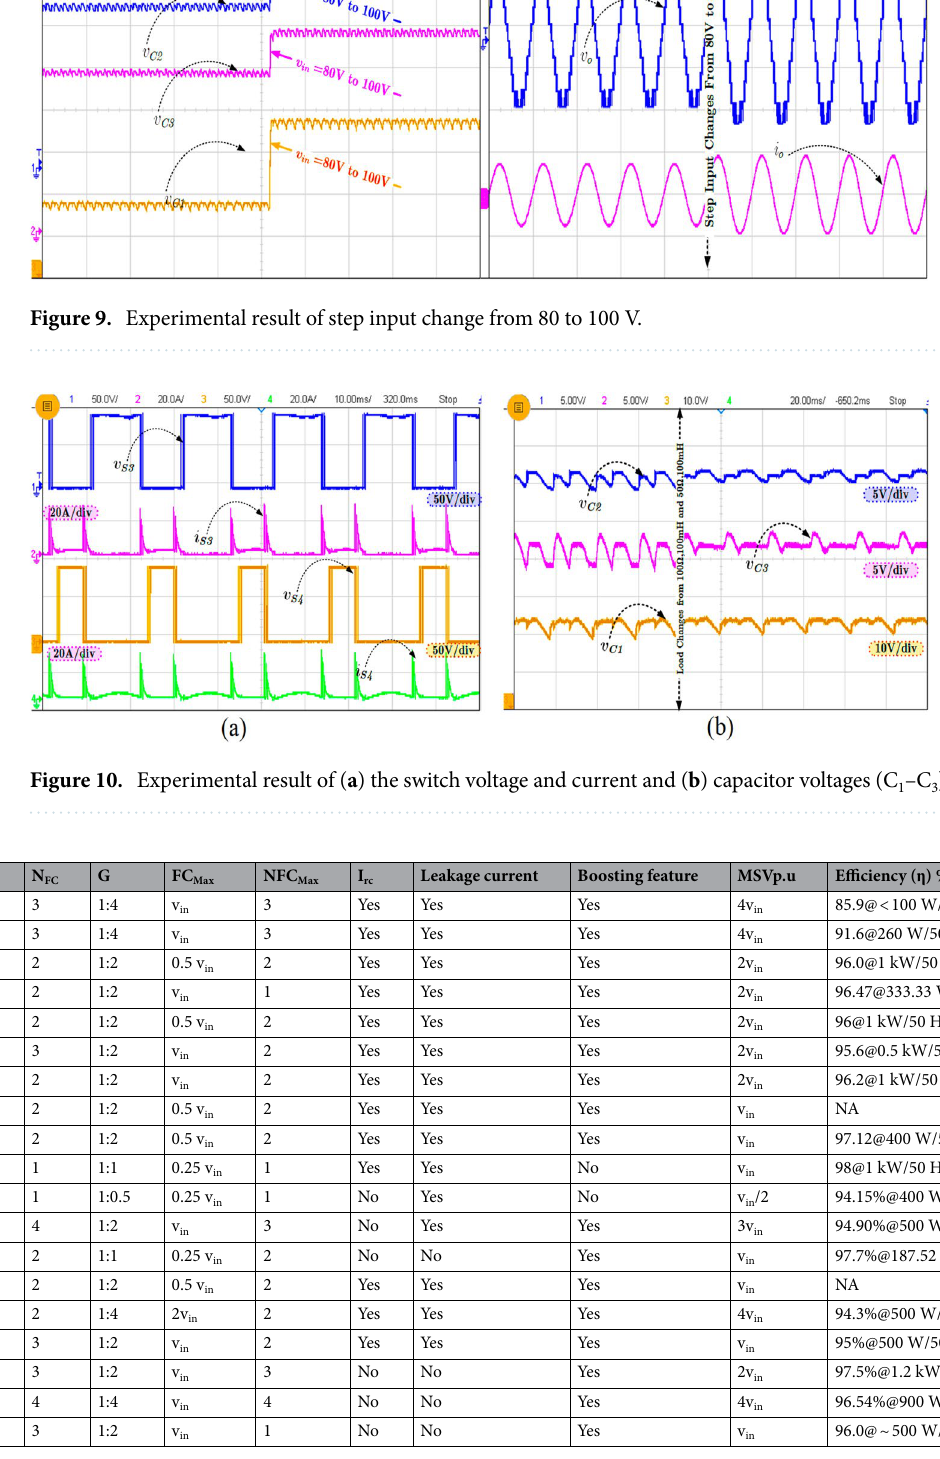
Table 3. Comparison of proposed topology with other recent nine-level inverter topologies. N SW /N GD / N D /N FC —number of switches/gate driver/diode/floating capacitor, T Comp —total component count, F CMax — maximum voltage rating of FC, NFC Max —Number of FCs with maximum voltage rating, MSV p.u —Maximum Standing Voltage, I rc —Inrush